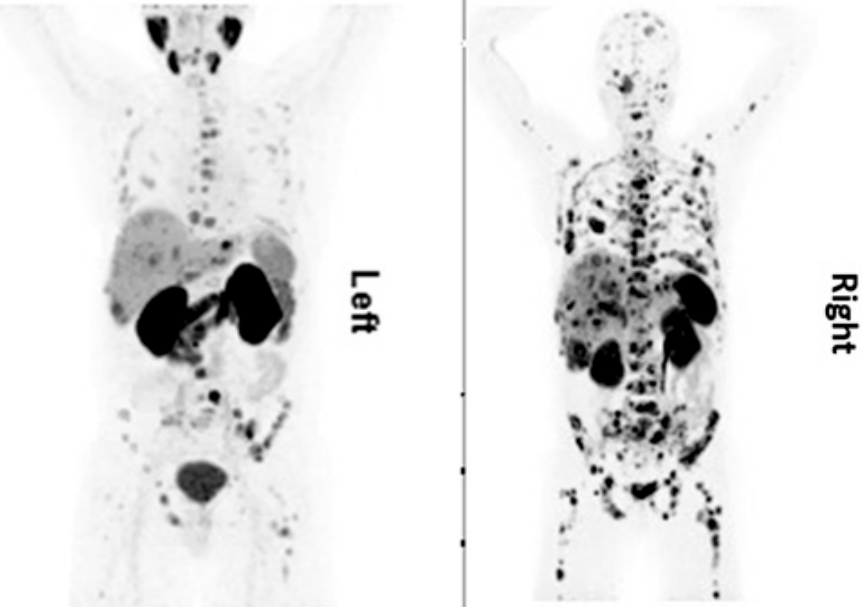
Figure 1. A 61-year-old patient, first diagnosed in 08/2015 with histological diagnosis of adeno- carcinoma of prostate, Gleason score 5 + 4, was referred for radioligand therapy due to disease progression after treatment with firmagon, docetaxel, lucrin, external beam radiation therapy and 1 cycle of cisplatin/cabazitaxel. His lab values showed PSA < 0.01 µ g/L, CgA 767 ng/mL,